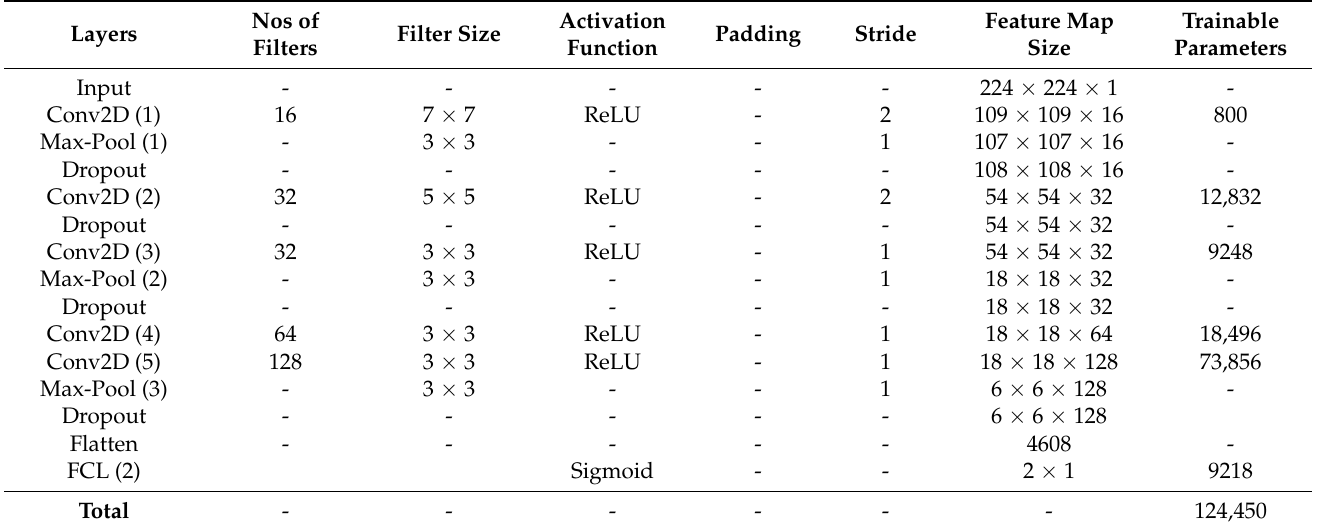
Table 3. Tabular representation of the 5-layered traffic congestion classification